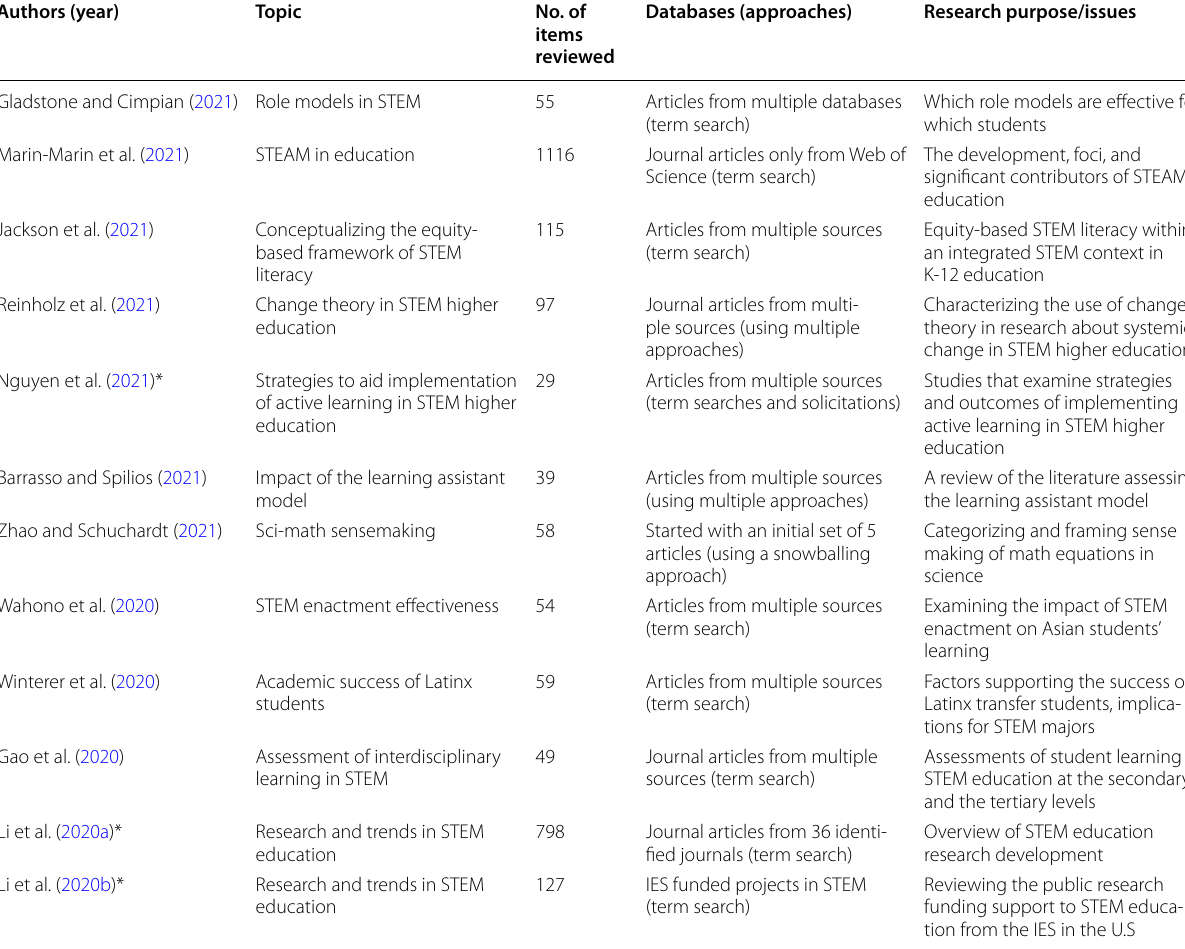
Table 1 Summary of research reviews on STEM education published in International Journal of STEM Education in 2020 and